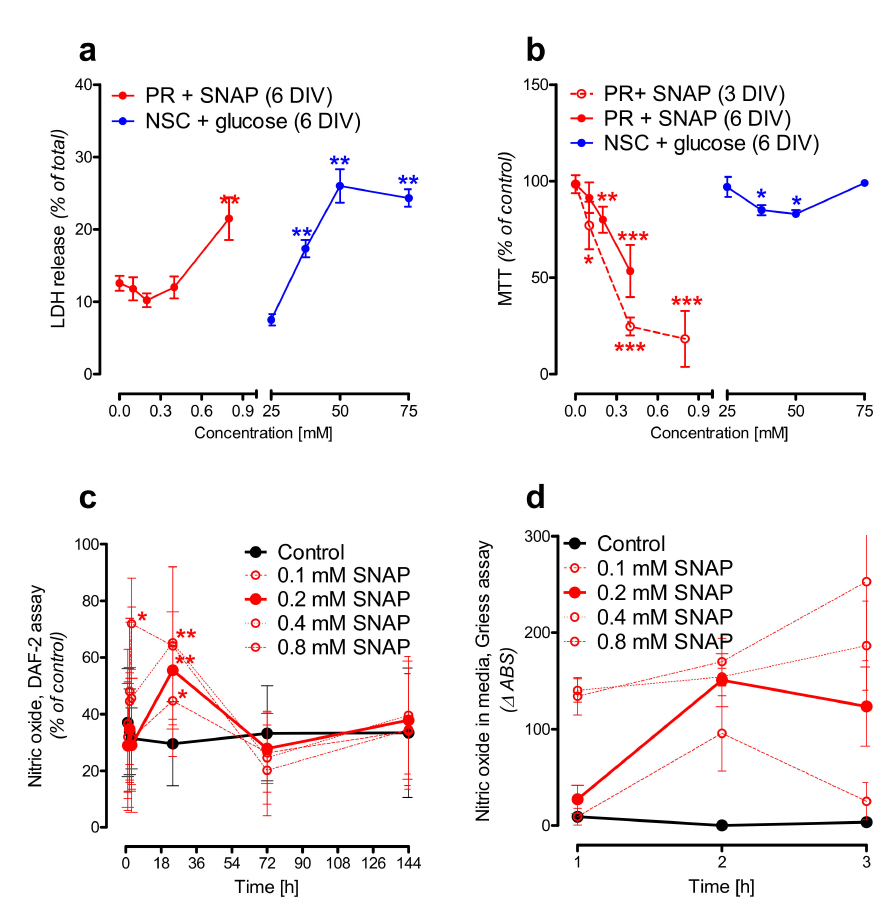
Figure 5. The impact of toxic factors on primary cells. ( a , b ) viability tests in both primary cell lines; ( c , d ) nitric oxide accumulation in primary neurons (PR). ( a ) LDH in media test; ( b ) methylthiazolyldiphenyl-tetrazolium bromide (MTT) test; ( c ) intracellular accumulation of nitric oxide (DAF-2 fluorescence assay); ( d ) in media accumulation of nitric oxide (Griess spectrophotometric assay). Data are means ± SD from 3 to 20 observations per group. Significantly di ff erent from the control: * ( p –value < 0.05), ** ( p –value < 0.01), *** ( p –value <